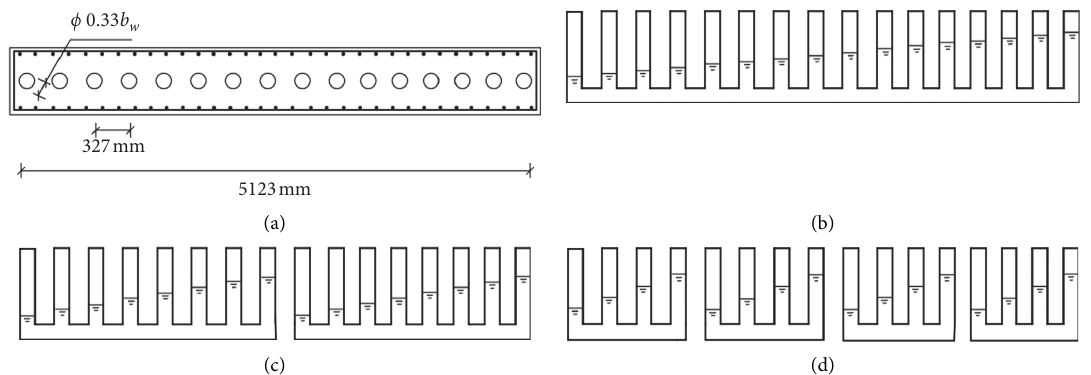
Figure 10: One-layer vertical column arrangement organized into (a) one 16-column TLMCD, (b) two 8-column TLMCDs, and (c) four 4- column